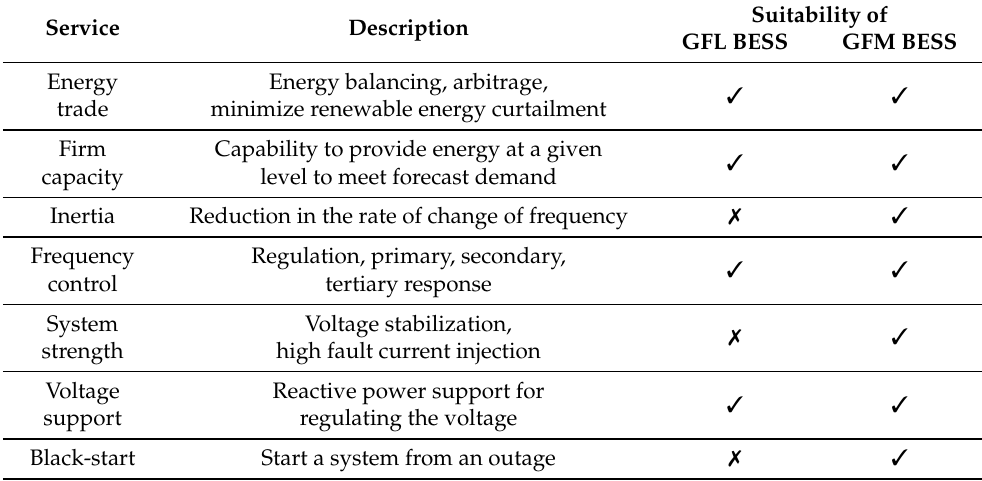
Table 4. Grid services of battery energy storage